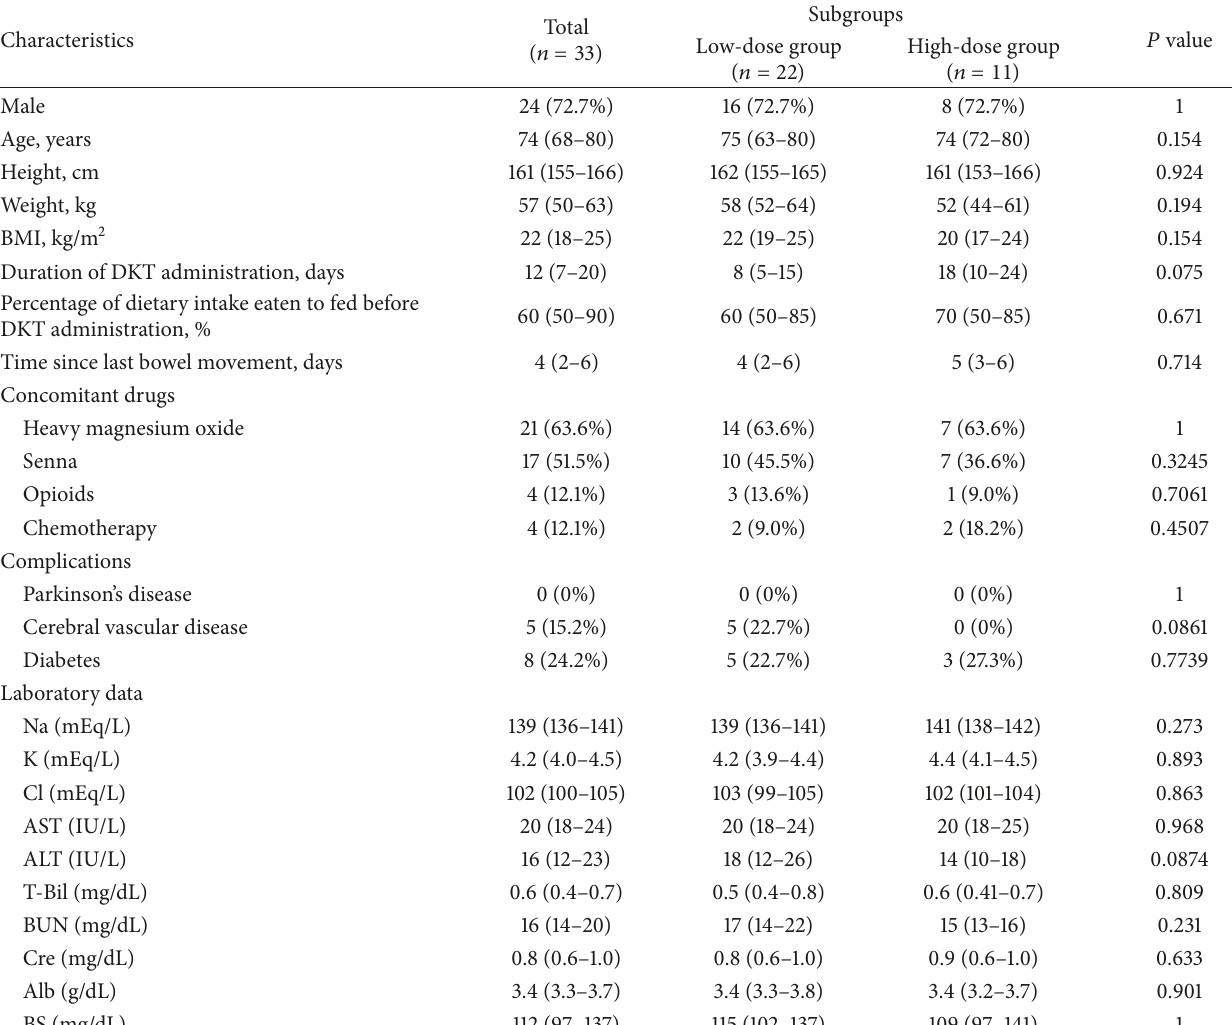
Table 1: Baseline characteristics of patients.